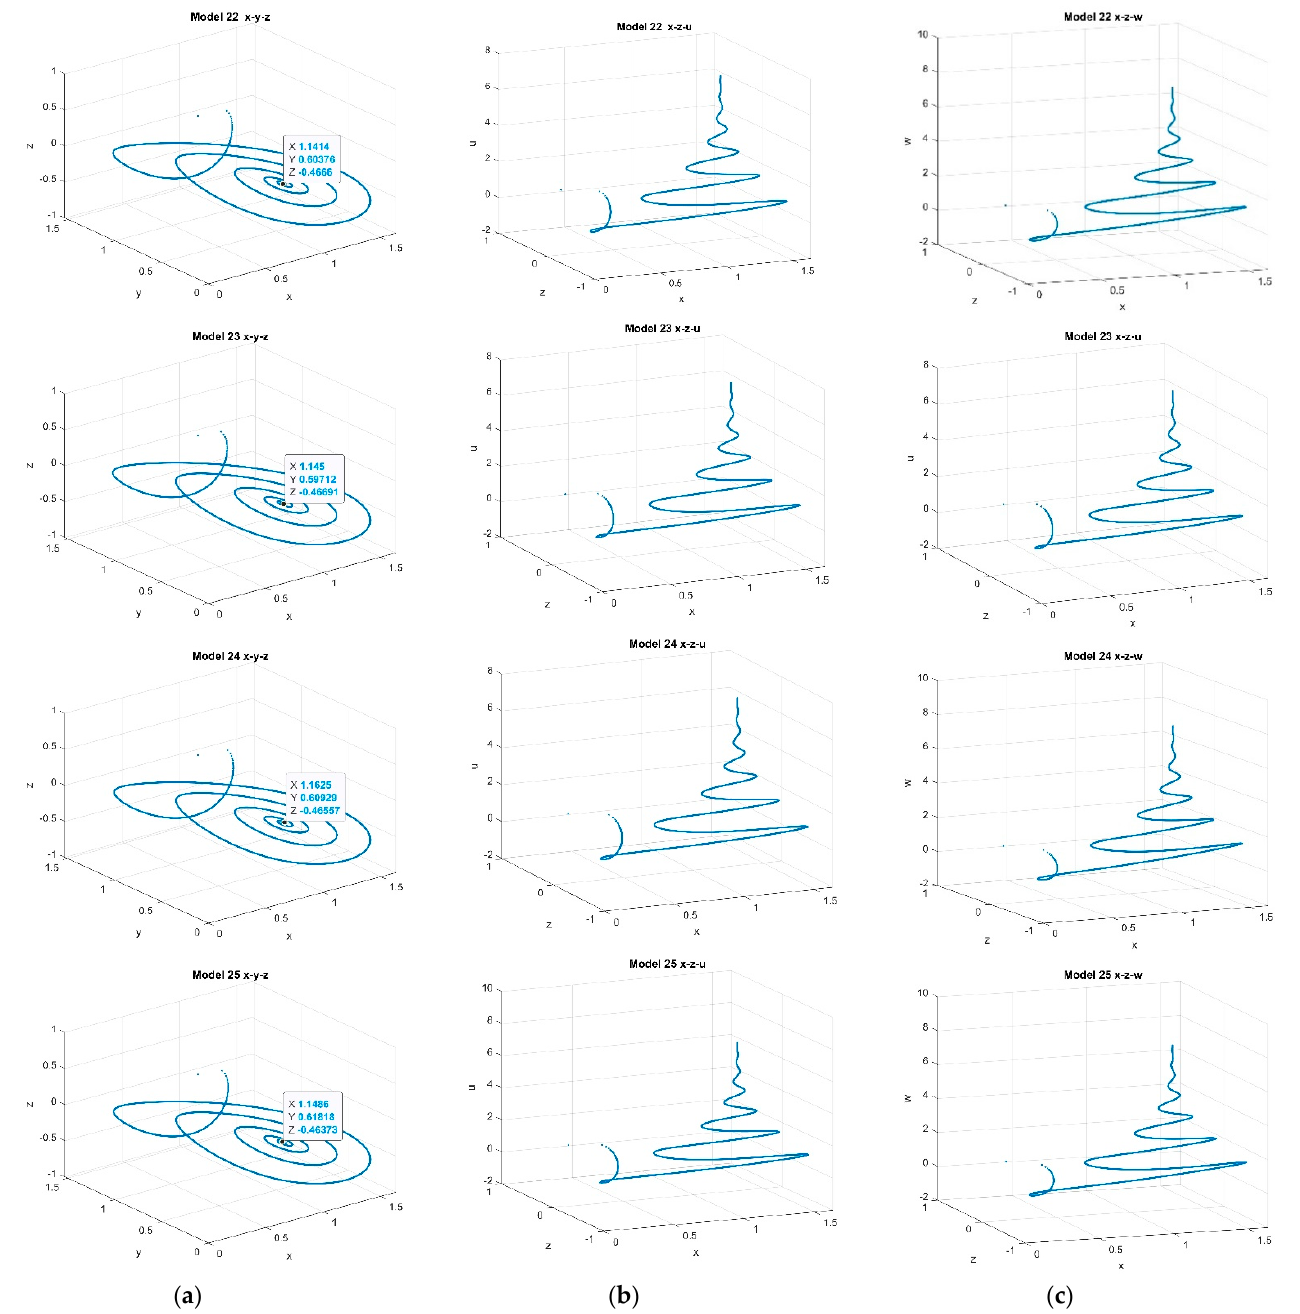
Figure 3. Phase portraits ( a ) x − y − z , ( b ) x − u − z , ( c ) x − z − w , at h = 0.002, k = 2, p = 1, α 5 = 0.232 for models (22) through (25).